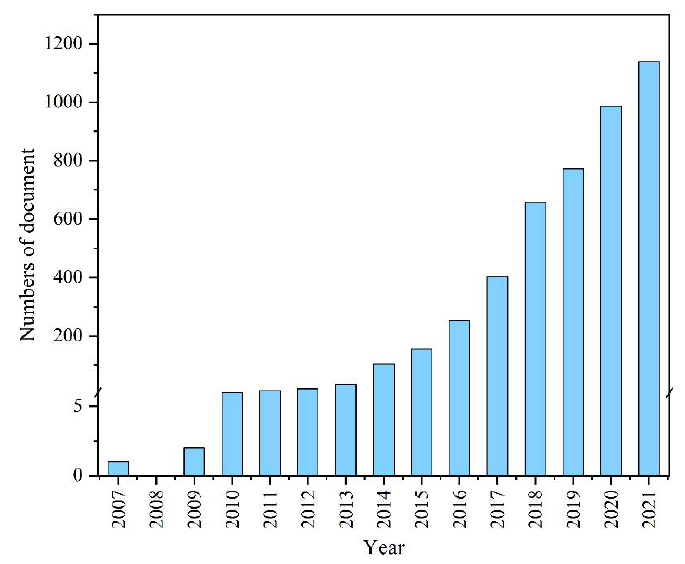
Figure 1. Graph of the number of literature references over the years.